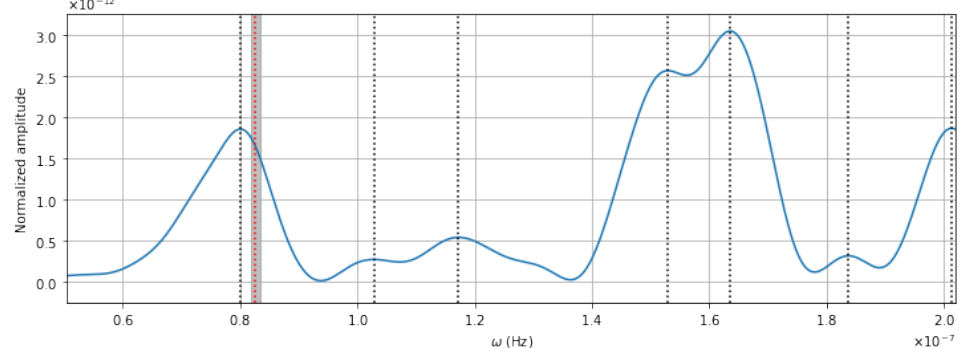
Figure 8. Plot of the LS periodogram of the averaged narrowband post-fit whitened TRs of the MSP J2145–0750. The black-dotted lines indicate the angular frequencies found by the LS algorithm. The × 10 − 8 expected for the GWs possibly red-dotted line indicates the angular frequency ω = 8.262 + 0.025 − 0.025 emitted by the SMBHB candidate PKS 2131–021. The gray shaded area indicates uncertainty on ω at the 3 σ confidence level. The horizontal axis indicates the GW angular frequency, expressed in Hertz. The vertical axis indicates the normalized amplitude, dimensionless.